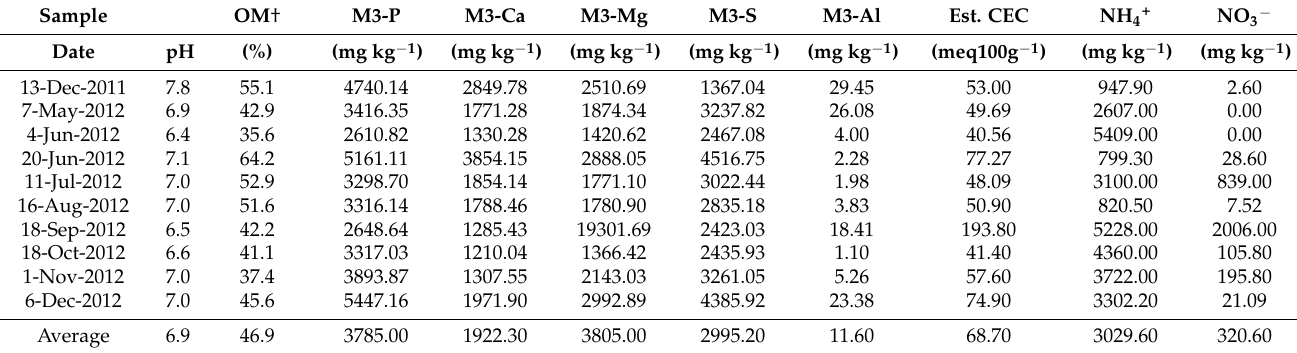
Table 2. Characteristics of the poultry manure at the farm, Kent County, Delaware, USA.